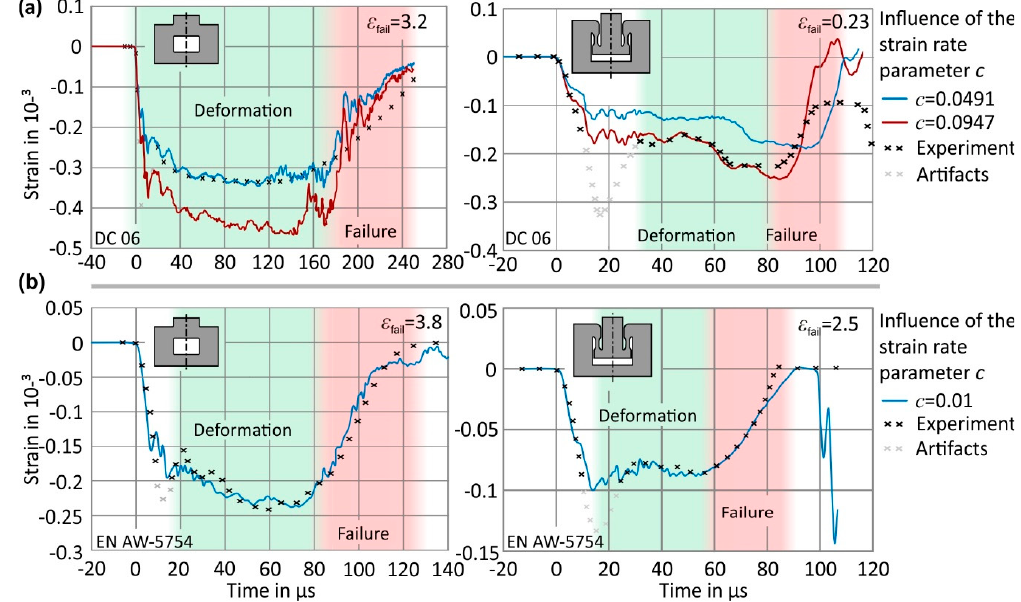
Figure 17. Comparison of experimentally and numerically determined elastic strain-time curves on the measuring body for shear and tensile specimens of DC06 ( a ) and EN-AW5754 H111 ( b ) at a hammer velocity of approximately 30 m/s.